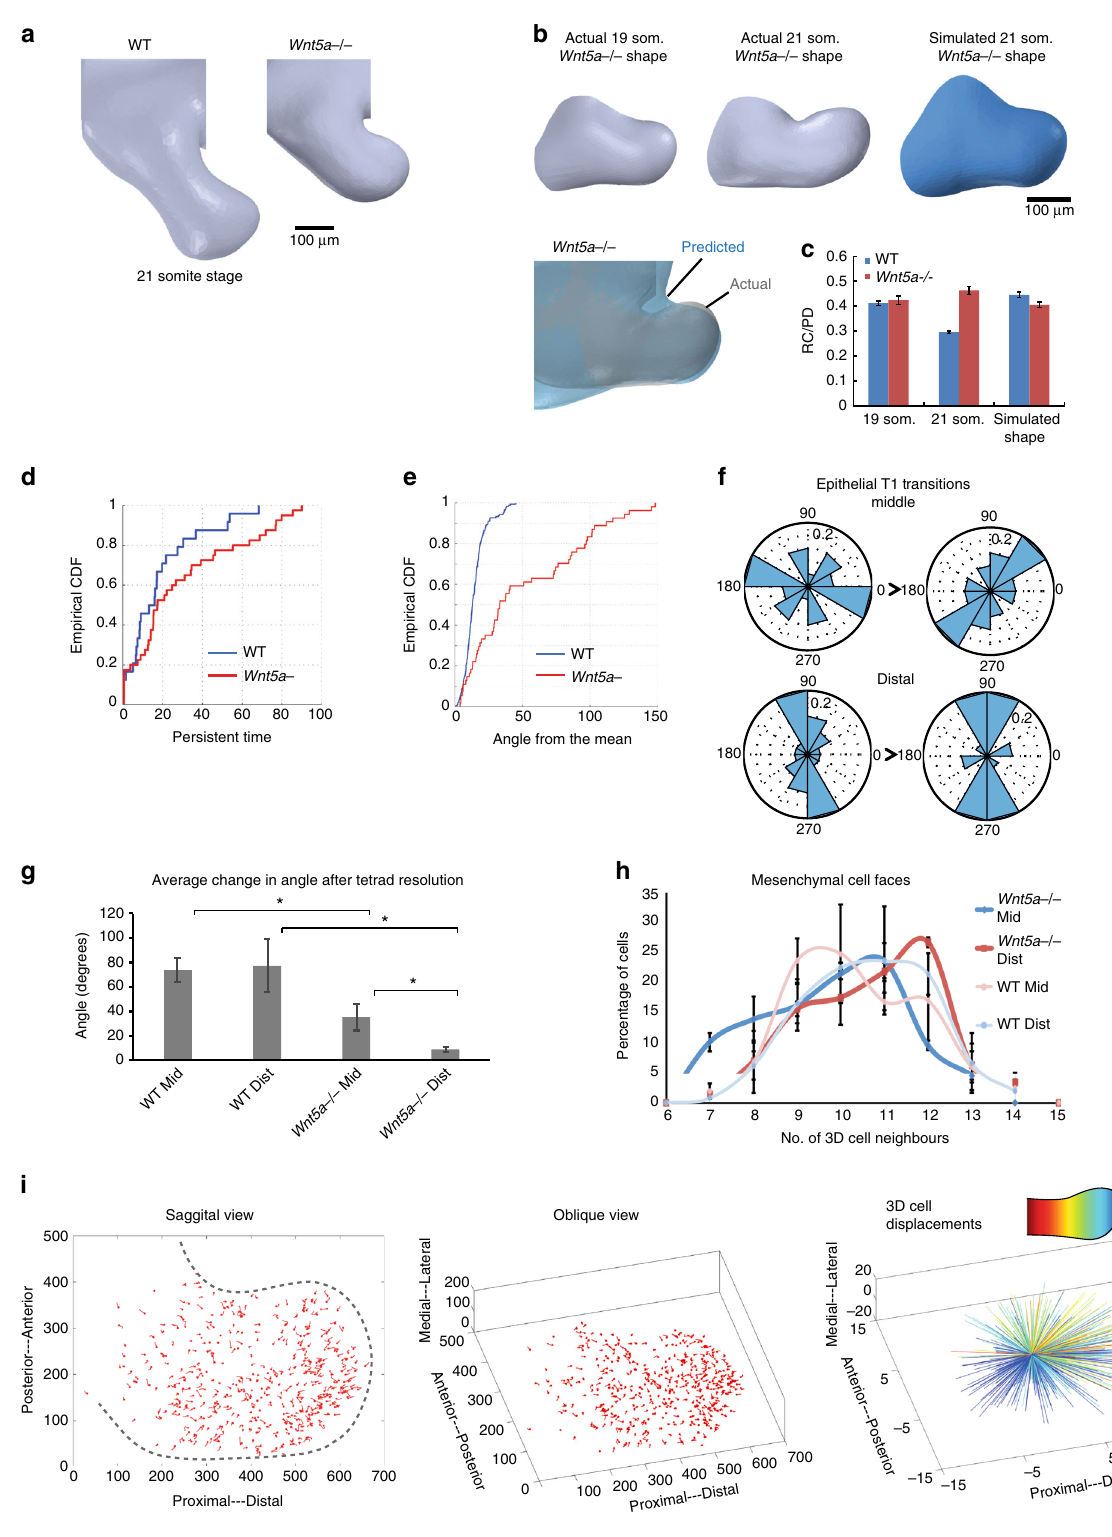
chick model, the implication of YAP/TAZ and PIEZO1 downstream of WNT5A suggests that multiple processes are likely affected by mutations that cause Robinow syndrome. Combining increasingly accurate biophysical approaches with genetics will likely help to de fi ne morphogenesis pathways, including those that coordinate cell polarity with physical